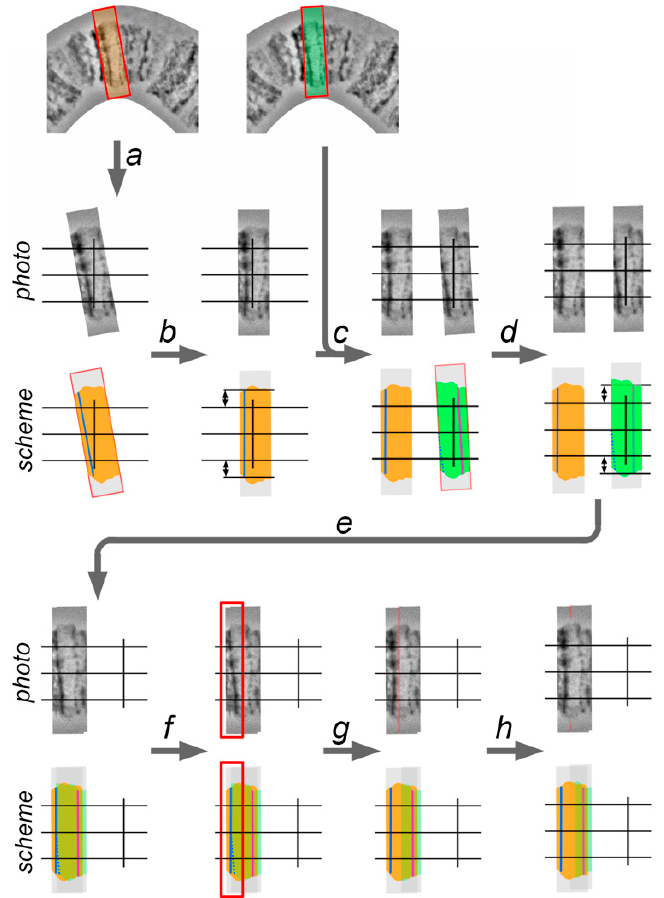
Figure 6. A workflow of chromosome straightening; example for the region with two bands: a—selection, which includes two adjacent bands, using “Lasso Tool” or “Rectangular Marquee Tool,” copying and moving the new layer with “Move Tool” to the work field; b—rotation and movement of the new layer (orange area) with “Move tool”, applying the “Transform” function, and adjustment of the first band (blue line), vertically, relative to the vertical guideline; the distance between marginal points of the band is the same relative to the outer horizontal lines; c—new selections on the template chromosome image, which include the whole second band and the whole, or at least part, of the first band (dotted blue line); copying selection and moving the new layer to the work field; d—rotation and movement of the second layer (green area) with “Move tool”, applying “Transform” function, and adjustment of the second band (magenta line), vertically, relative to the vertical guideline; the distance between marginal points of the band is the same relative to the outer horizontal lines; e—the second layer is brought to the front and overlapped with the first layer using “Move Tool”; the axial part of the first band on the second layer coincides with the axial part of the first band of the first layer (varying the opacity of the second layer is useful); f—a new selection in the work field, which includes the first band of the second layer (blue dotted line) and a region of the second layer which covers the first band of the first layer (blue line) using “Lasso Tool” or “Rectangular Marquee Tool”; g—deletion of selection; h—blurring the left border of the second layer, using “Eraser Tool” with smooth border brush or “Blur Tool”, to make a gradual transition from the first layer to the second layer.